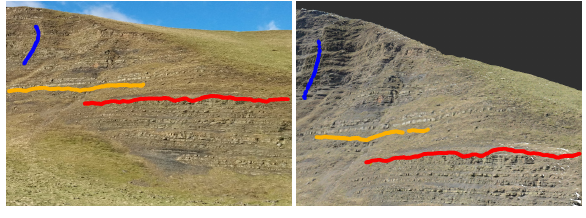
Figure 10: Geological annotation mapping of a virtual outcrop model from mobile device imagery.